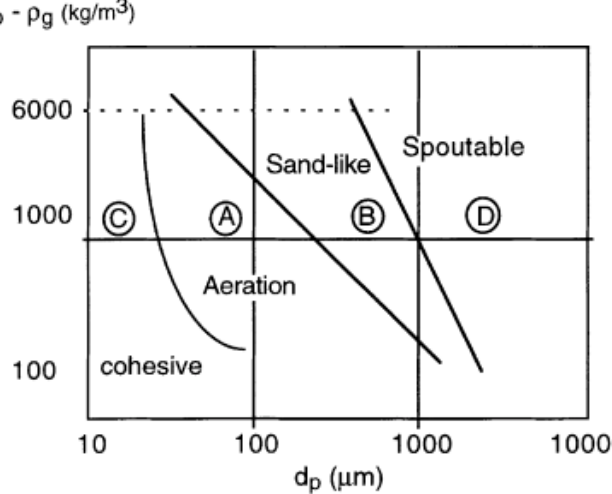
Figure 8. The Geldart classification of particles [28].